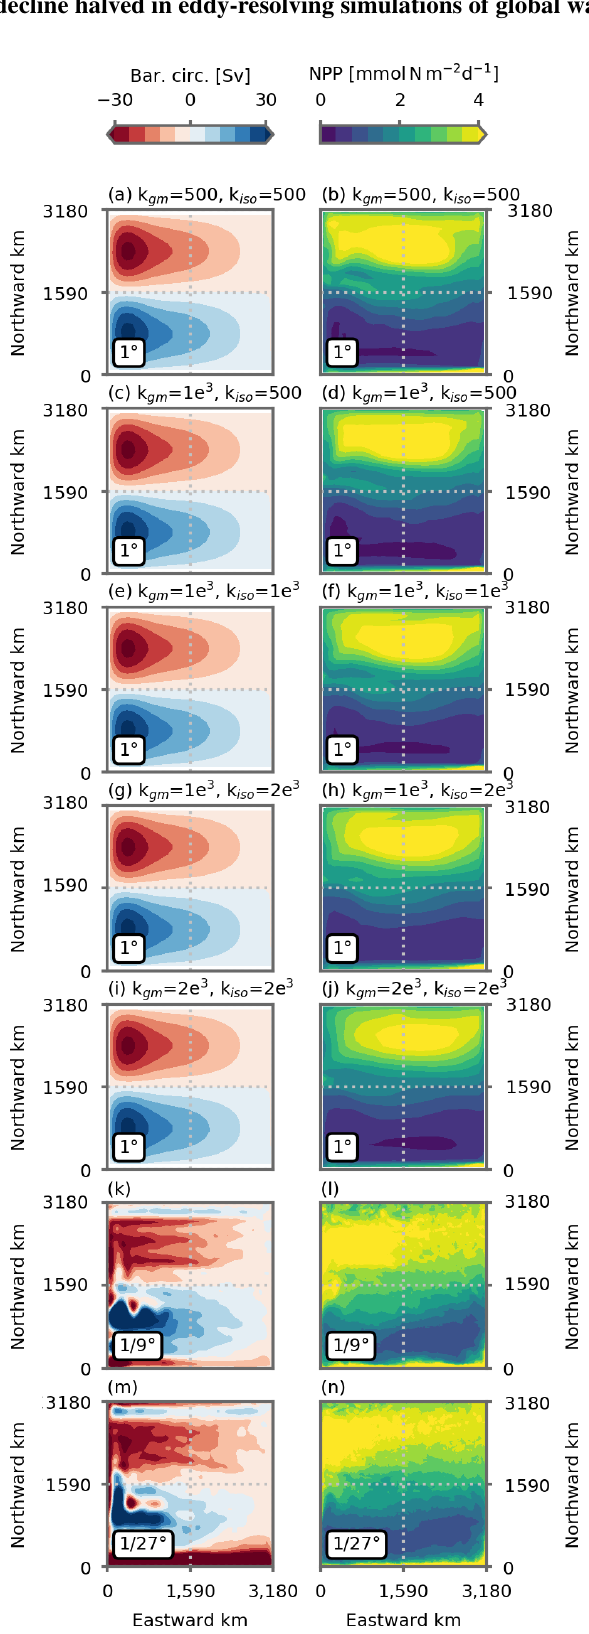
Figure A2. The left column shows barotropic circulation (Sv), and the right column shows vertically integrated net primary production (NPP, mmolNm − 2 d − 1 ) in preindustrial control simulations. Panels (a) – (j) show the five 1 ◦ resolution configurations, and (k) – (n) show the 1 / 9 and 1 / 27 ◦ resolution configurations. All figures show the average over the last 5 years of the simulations (years 66 to 70).